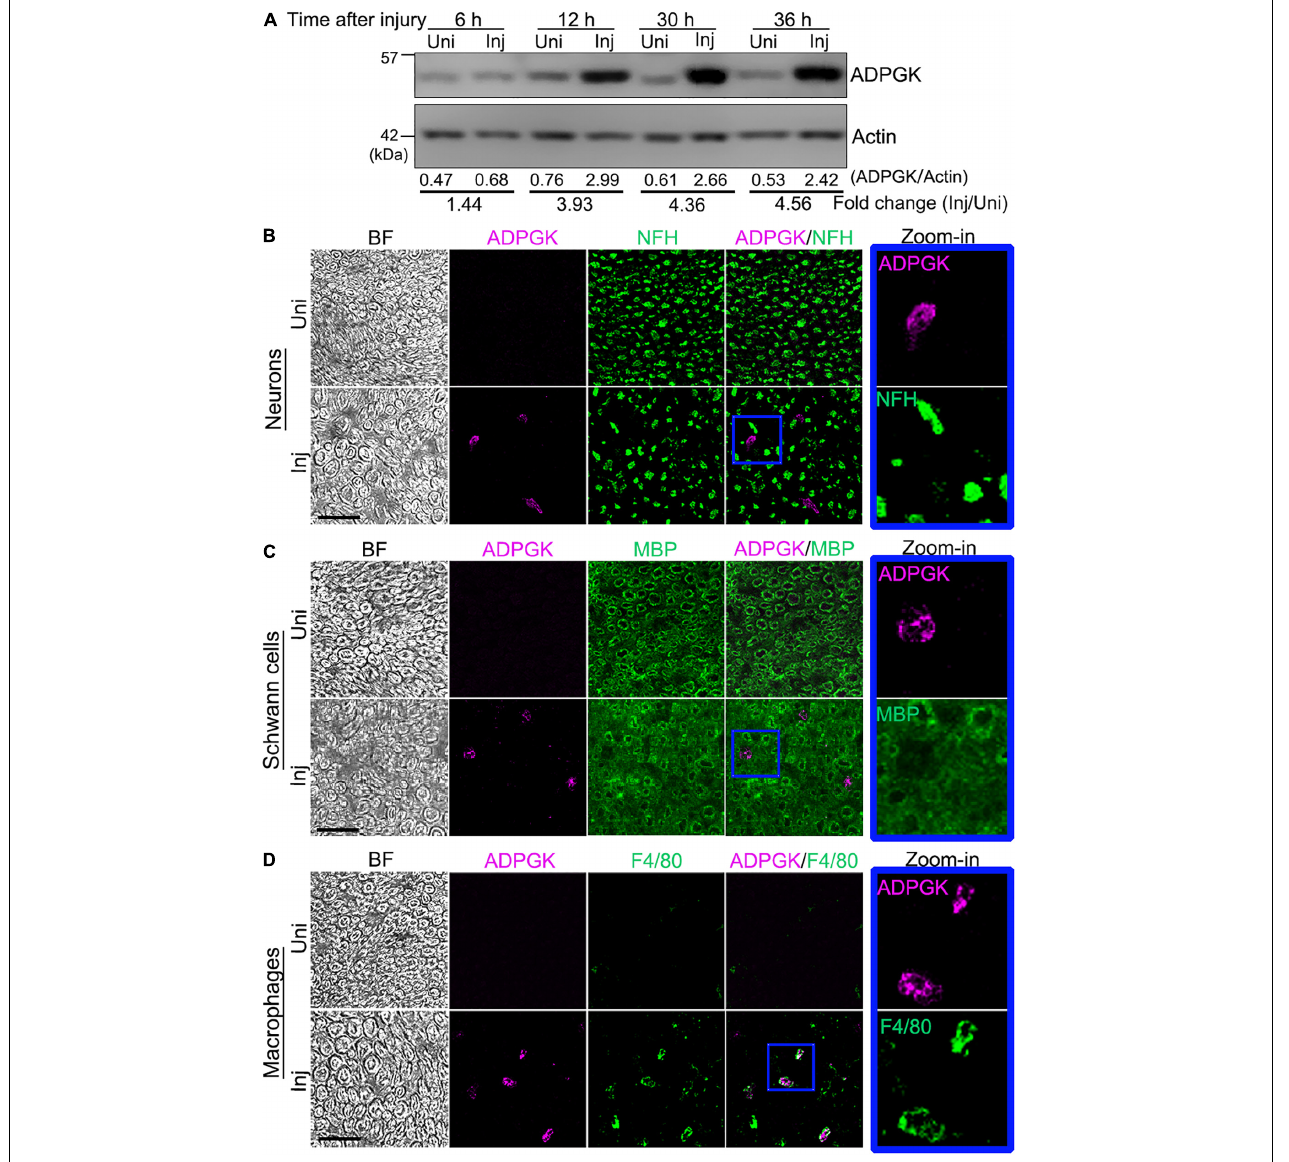
FIGURE 3 | ADPGK is increased in the injured sciatic nerve and co-localized with macrophages. (A) Western blot analysis of ADPGK in the mouse sciatic nerve at indicated time points after injury. The relative protein levels of ADPGK (normalized to Actin) and the fold change (injured/uninjured) are shown. Also see Supplementary Figures 2A,B . (B–D) Representative images of the immunohistochemistry analysis of the cross sections of the mouse sciatic nerve co-immunostained for ADPGK and the neuro-axonal marker NFH (B) , Schwann cell marker MBP (C) or macrophage marker F4/80 (D) at 12 h after injury. Higher magnification images (zoom-in) of the individual channels of the blue-boxed areas are shown by the side. BF, bright field. Uni, uninjured; Inj, injured. Scale bars: 25 µ